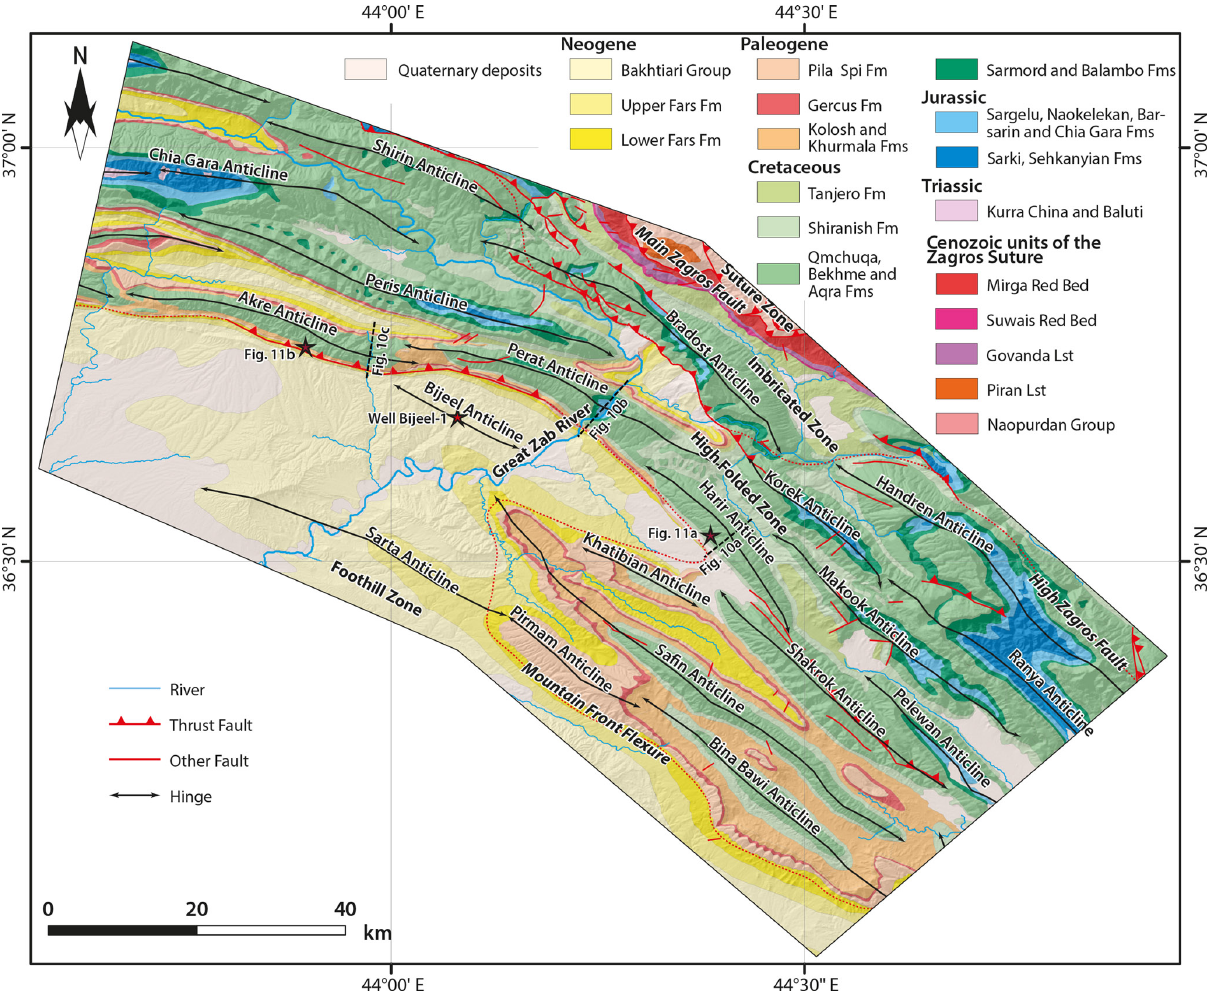
Figure 2. Geological map of the Zagros Fold–Thrust Belt in KRI showing the location of the three anticlines Harir, Perat, and Akre with respect to the MFF that separates the High Folded Zone from the Foothill Zone (modified after Csontos et al., 2012; Sissakian, 1997; Zebari and Burberry,